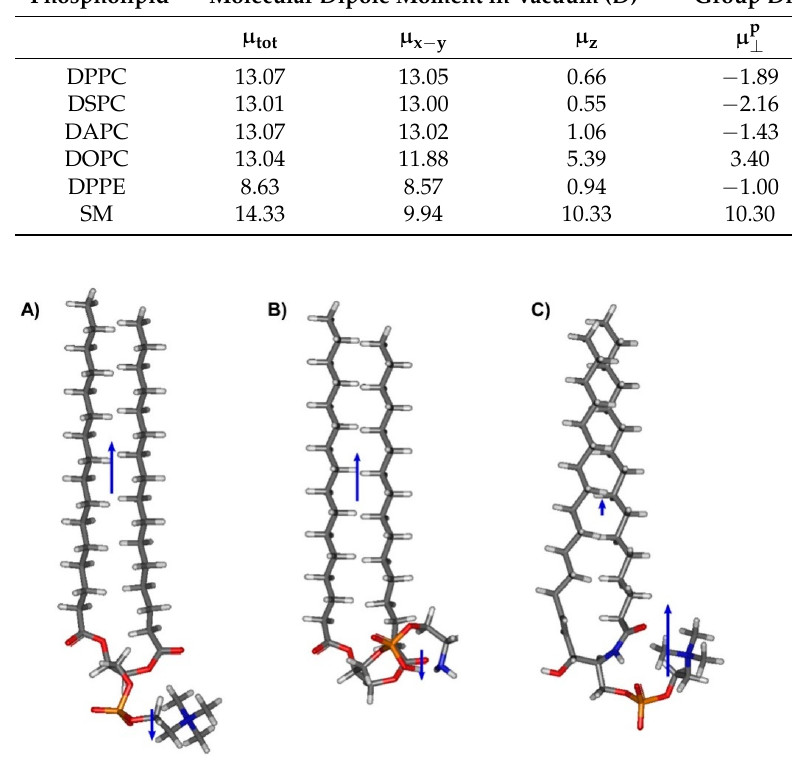
Figure 4. Molecular structure of selected phospholipids: DPPC ( A ), DPPE ( B ) and SM ( C ) with the directions of normal components of electrical dipole moment visualized separately for the polar group ( µ p ⊥ ) and hydrocarbon chains ( µ a ⊥ ). Carbon atoms are visualized in dark gray, hydrogen in bright gray, oxygen in red, nitrogen in blue and phosphorus in orange.